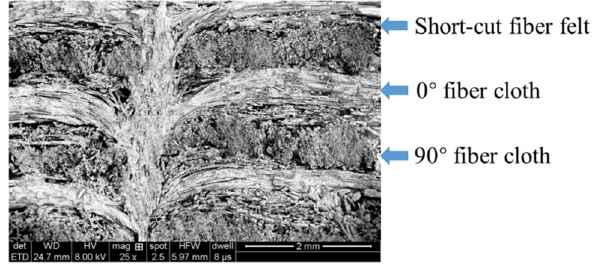
Figure 1: Structures of NP C/Cs [ 19